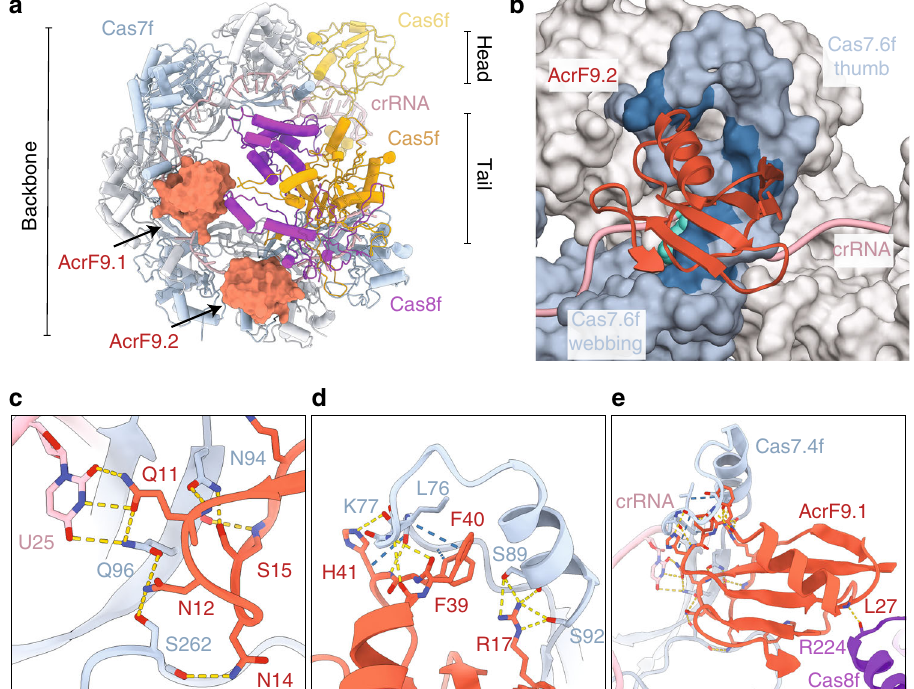
Fig. 1 Cryo-electron microscopy structure of the Csy – AcrIF9 complex. a Model of the Csy – AcrIF9 complex, Csy subunits shown as pipes and planks, Cas6f shown in yellow, Cas7f in light blue and gray, Cas8f in purple, Cas5f in orange and crRNA in pink, AcrIF9 shown in red surface representation. b The binding site of AcrIF9.2, residues interacting with AcrIF9 highlighted in blue (Cas7.6f) and green (crRNA). Cas7f subunits shown in surface representation, crRNA and AcrIF9 in cartoon representation. c – e Detailed view of the AcrIF9 binding site, model shown in cartoon representation, interacting residues shown as sticks. Interactions with uridine 25 (U25) are expected to accommodate any base at the equivalent position. Hydrogen bonds are indicated by yellow dashes, hydrophobic interactions are indicated by blue